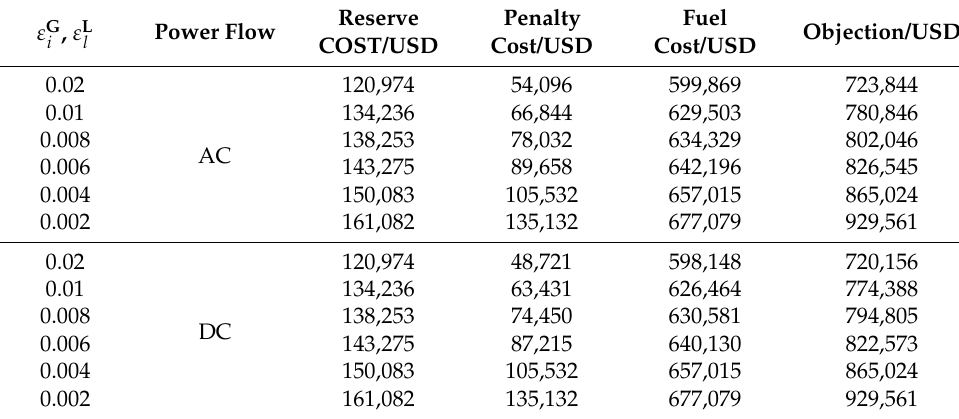
Table 3. Object value of different confidence